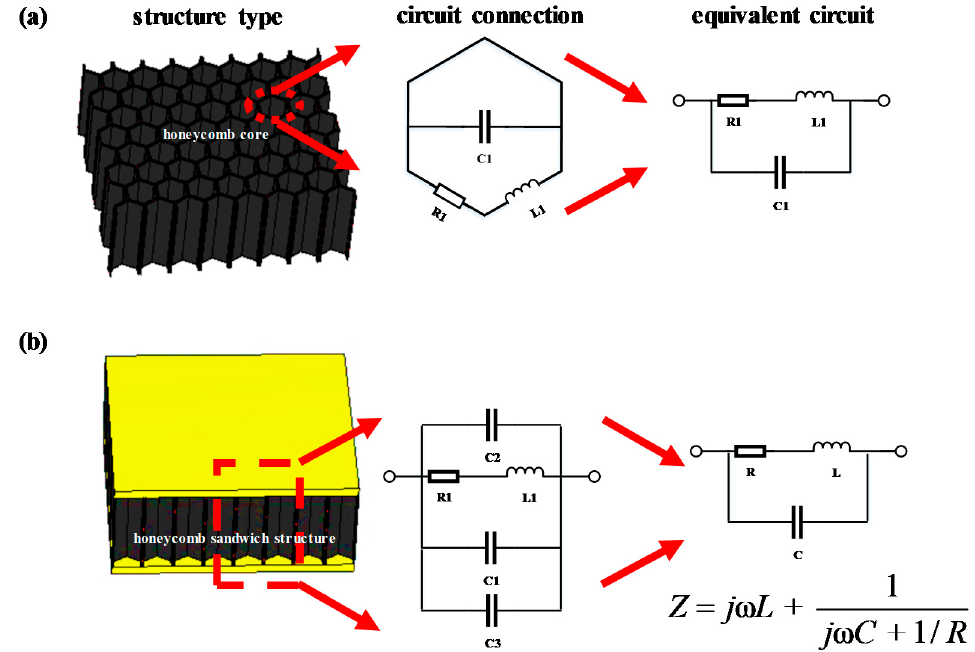
Figure 7. Equivalent circuit model for the ( a ) honeycomb and ( b ) honeycomb sandwich structure.